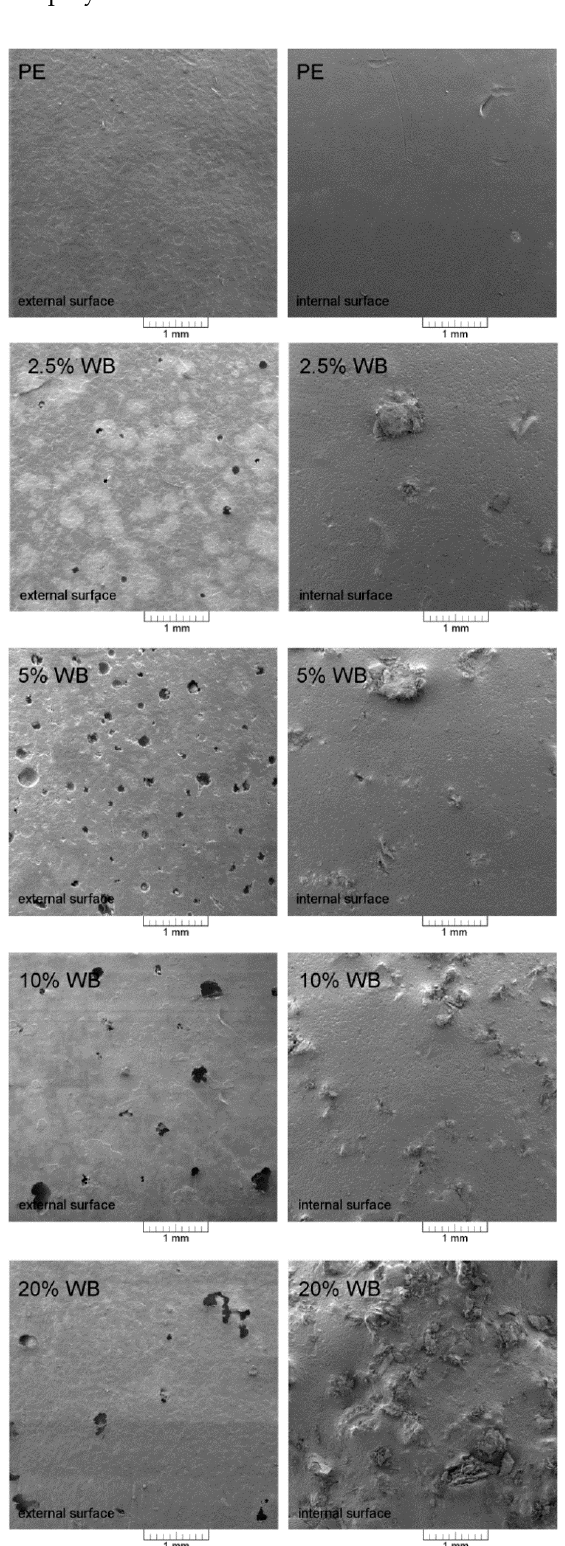
Figure 5. SEM images of rotationally-molded PE and PE-WB composites.